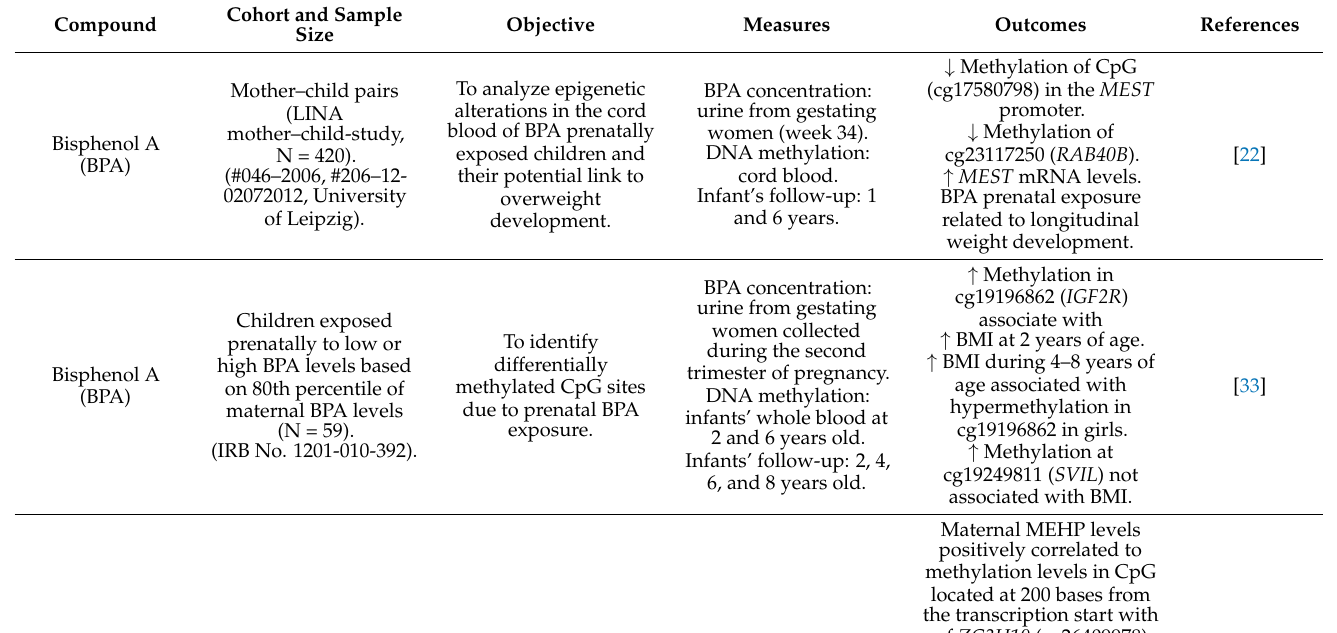
Table 3. Epidemiological studies addressing epigenomic changes related to childhood obesity development after maternal exposure to